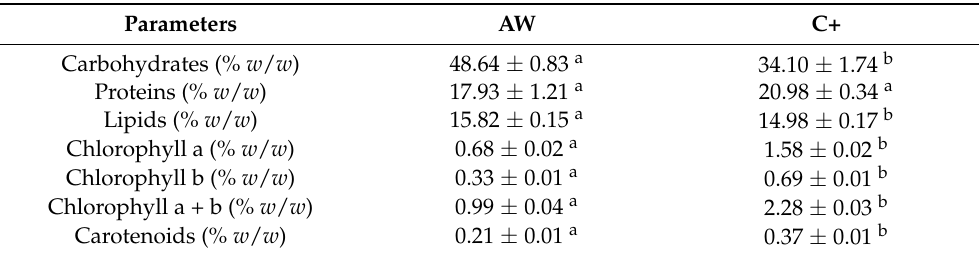
Table 5. Biochemical composition of the biomass in terms of carbohydrates, proteins, lipids, and photosynthetic